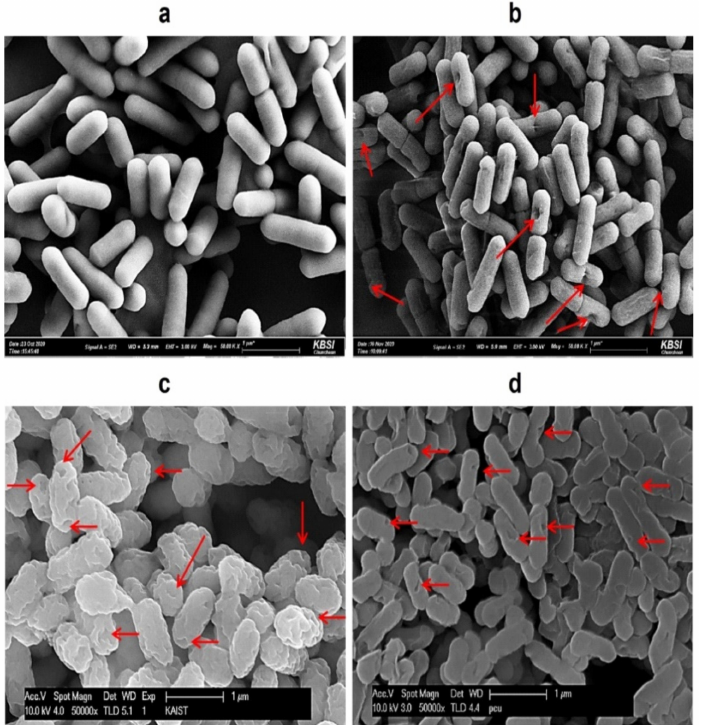
Figure 1. Comparison of SEM images of ( a ) wild-type L. monocytogenes cells; ( b ) HCl-induced LMGs; ( c ) H 2 SO 4 -induced LMGs; and ( d ) NaOH-induced LMGs. Small arrows show the trans-membrane lysis pores. Electron micrographs were taken by Hitachi S-4800 Field Emission SEM II ( a,b ) and